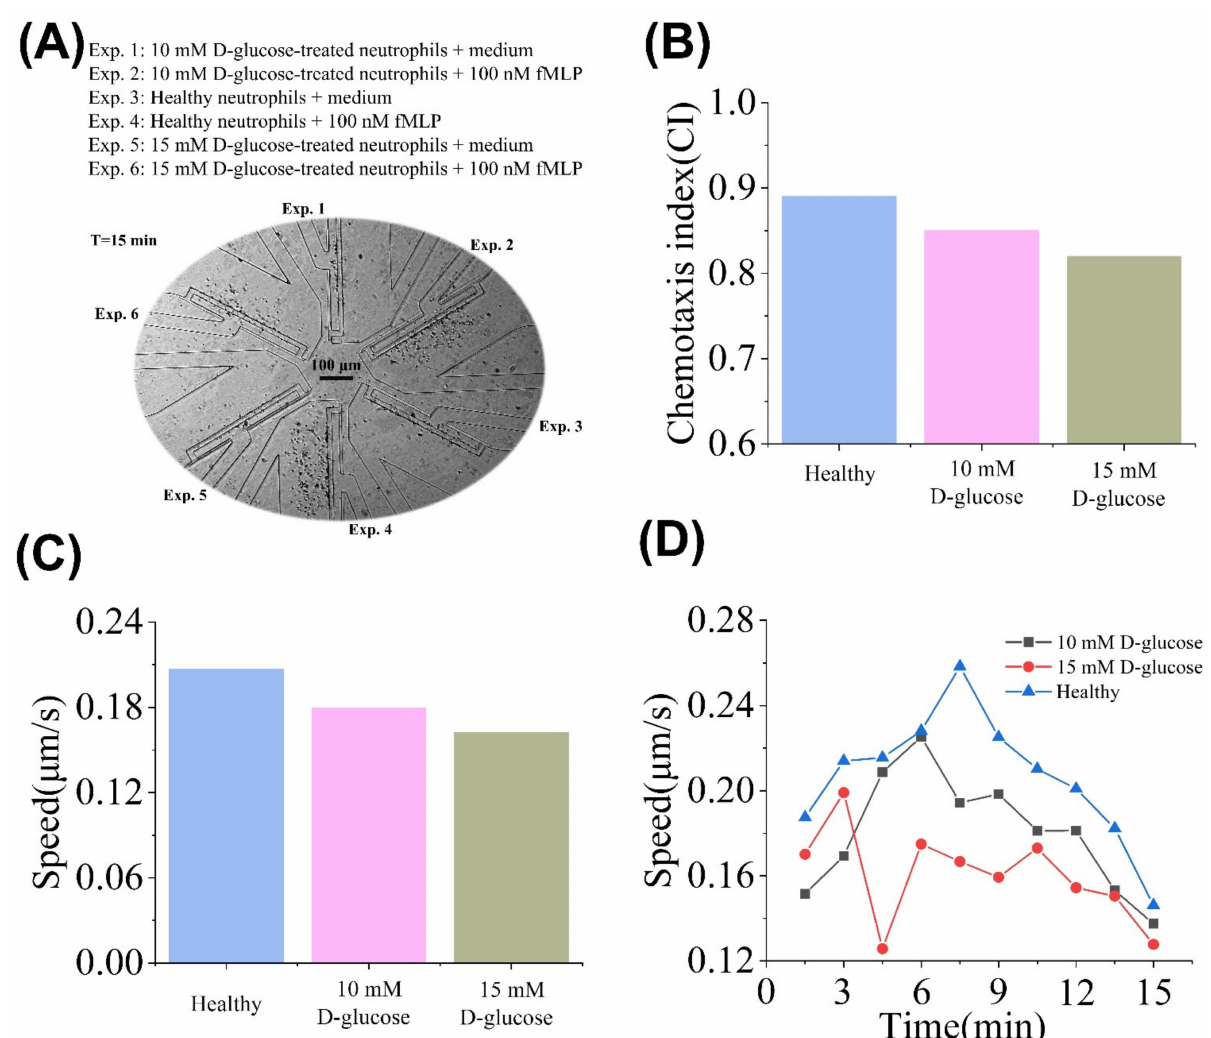
Figure 6. Chemotaxis comparison of the D-glucose-treated and control neutrophils. ( A ) Experiment images in the SC 2 chip after 15 min. ( B ) Average CI values of healthy neutrophils, 10, 15 mM of D-glucose-treated neutrophils. ( C ) Average V values of healthy neutrophils, 10, 15 mM of D- glucose-treated neutrophils. ( D ) Time-dependent V values of healthy neutrophils, 10, 15 mM of D-glucose-treated